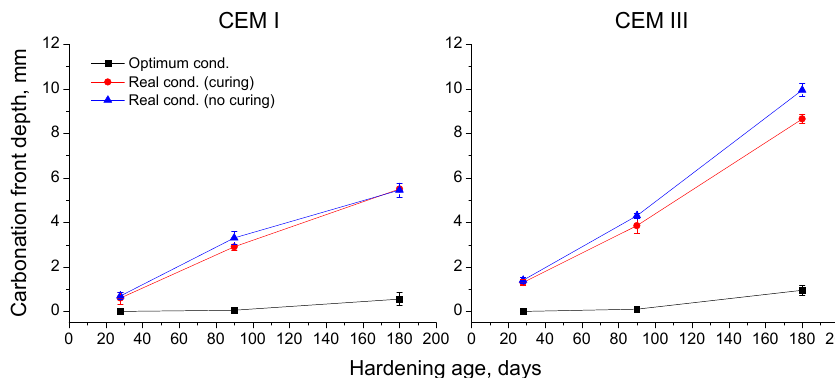
Figure 10. Evolution of carbonation front depth for CEM I and III specimens.